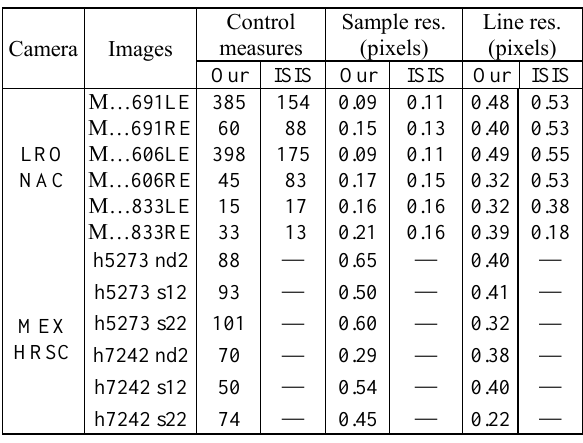
Table 4. Valid control measures and image coordinates residuals, where res. indicates residuals.